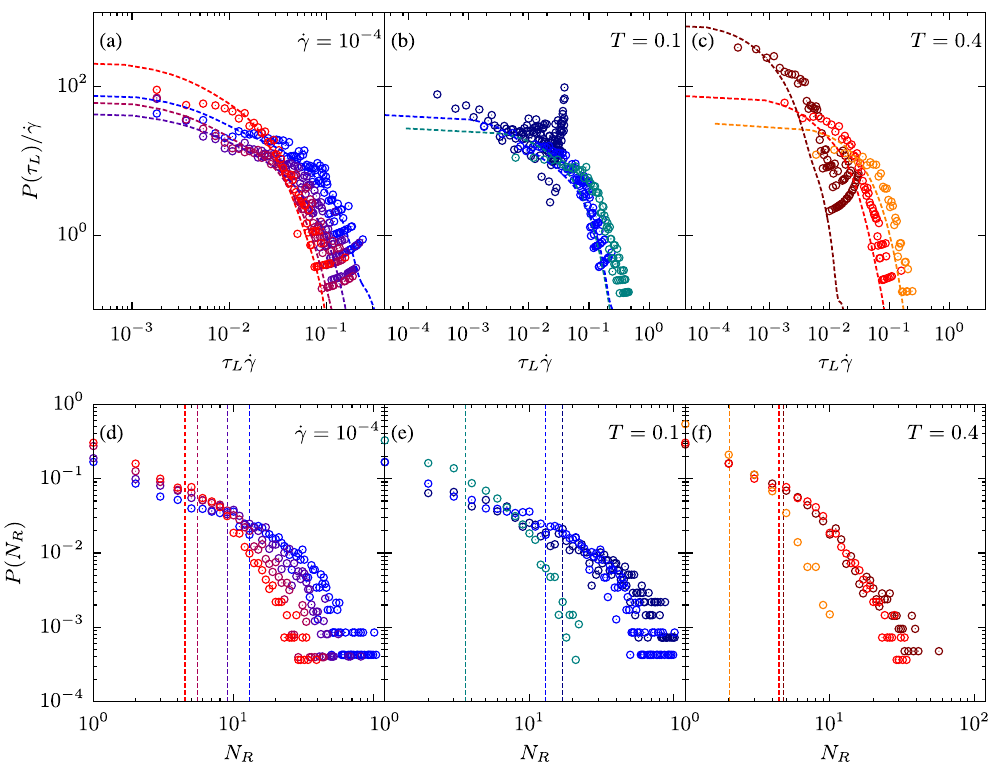
FIG. 6. (a) – (c) Probability distributions for single-soft-spot lifetimes at different temperatures and strain rates, respectively. In (a), temperatures of T ¼ 0 . 1 (blue) to T ¼ 0 . 4 (red) are shown at a strain rate of _ γ ¼ 10 − 4 . Overlaid in dashed lines are the predictions of the discrete model. In (b), we show lifetime distributions at strain rates of _ γ ¼ 10 − 5 (dark blue) to _ γ ¼ 10 − 3 (green) at a temperature of T ¼ 0 . 1 . Again, predictions from the discrete model are shown in dashed lines for strain rates of _ γ ¼ 10 − 4 and _ γ ¼ 10 − 3 . In (c), we show lifetime distributions at strain rates of _ γ ¼ 10 − 5 (brown) to _ γ ¼ 10 − 3 (yellow) at a temperature of T ¼ 0 . 4 . Predictions from the discrete model are overlaid in dashed lines. Figures (e) – (f) show the probability distributions for the number of rearrangements needed to destroy a single soft spot using the same color scheme as in (a) – (c). In all cases, we see that the number of rearrangements appears to be power- law distributed with an exponential tail. For each distribution, the mean number of rearrangements needed to destroy a soft spot is overlaid in a dashed